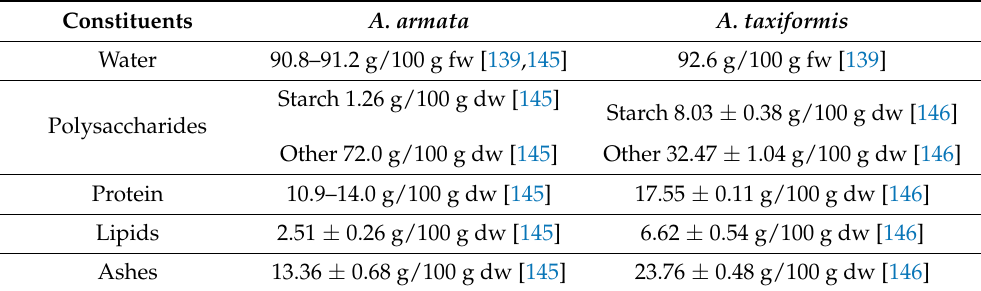
Table 6. General composition of Asparagopsis species.